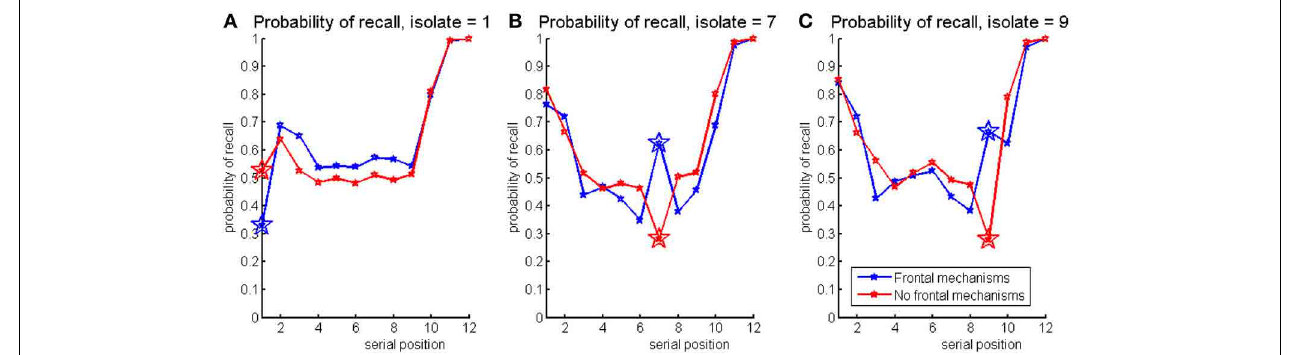
FIGURE 8 | Probabilities of recall for the model without (red) and with (blue) the frontal mechanisms, simulating Von-Restorff lists with isolate in the 1st (left) 7th (middle), and 9th (right) position.